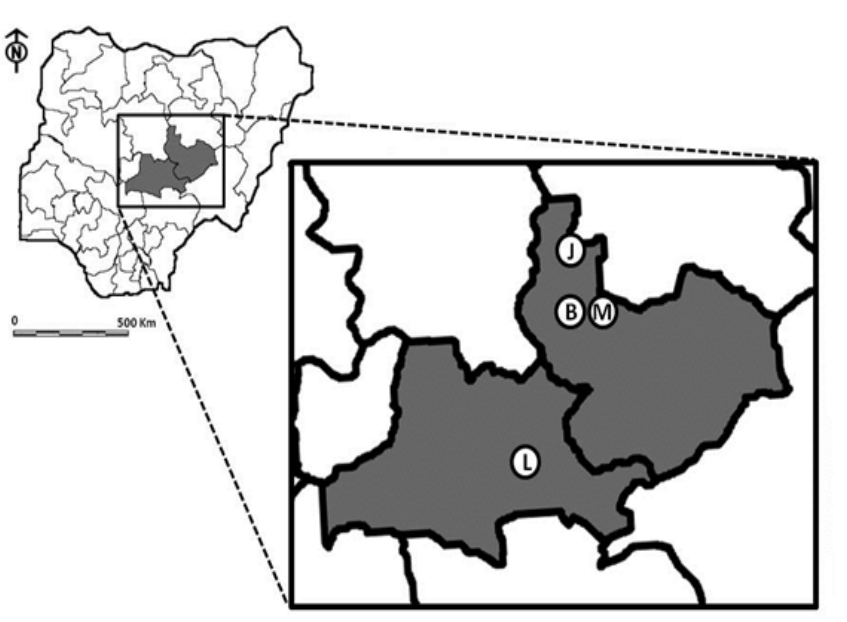
Figure-1. Map of Nigeria highlighting Nigerian regional borders. The amplifi- cation shows the Nigerian states (Plateau and Nassarawa) where sampling sites were located (J: Jos; B: Barkin Ladi; M: Mangu; L: